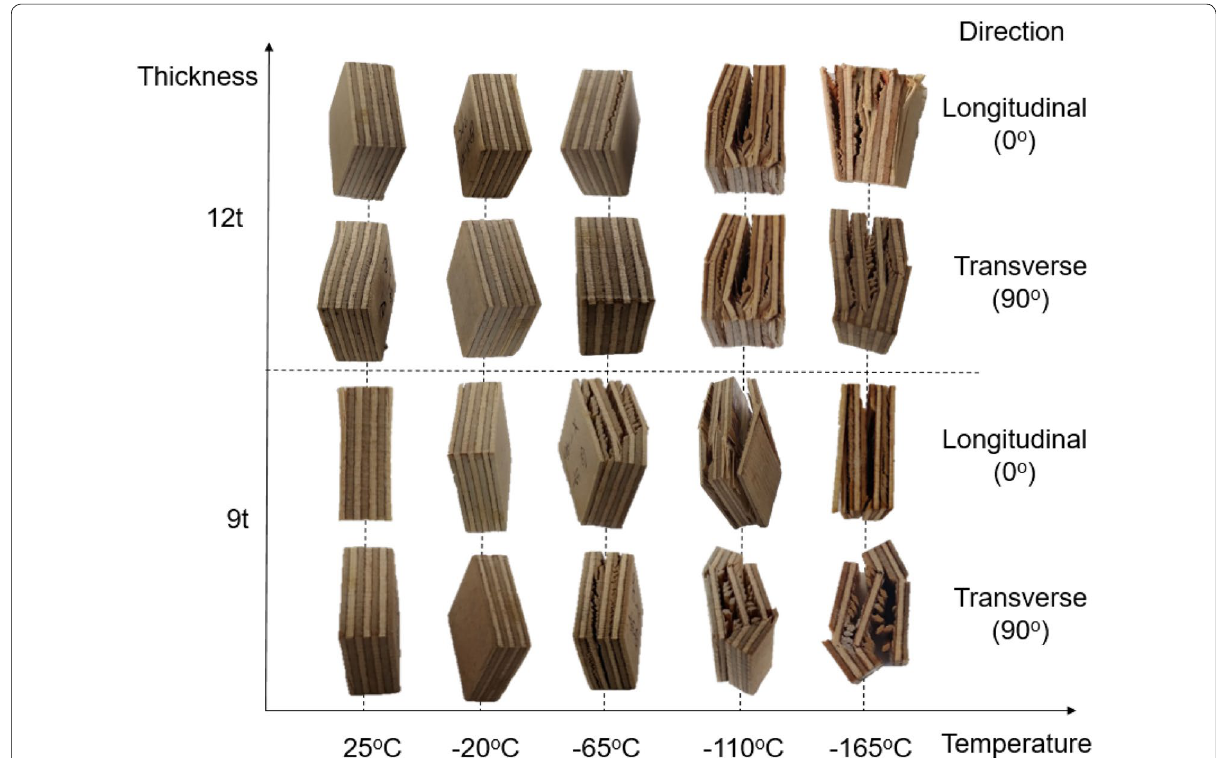
Fig. 16 Macroscopic images showing fracture characteristics of MUF plywood